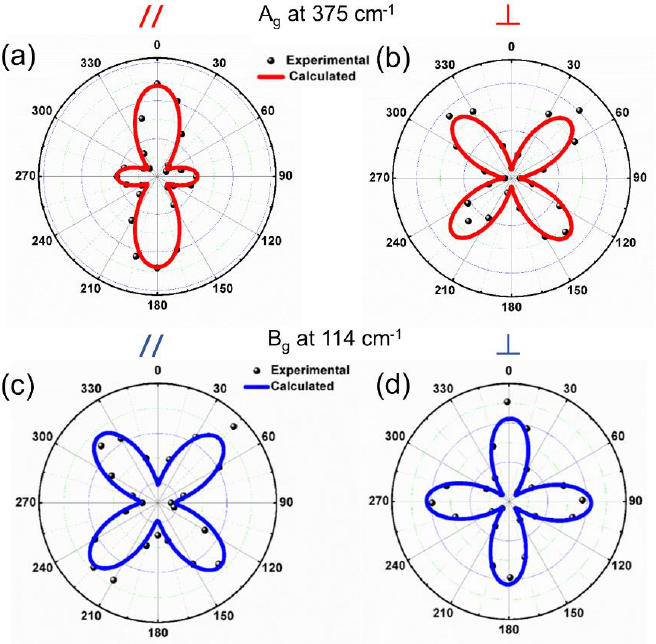
Figure 7. The anisotropic Raman intensities in polar coordinates under parallel and perpendicular polarization configurations for ( a , b ) A g mode at 375 cm − 1 and ( c , d ) B g mode at 114 cm − 1 , respec- tively.